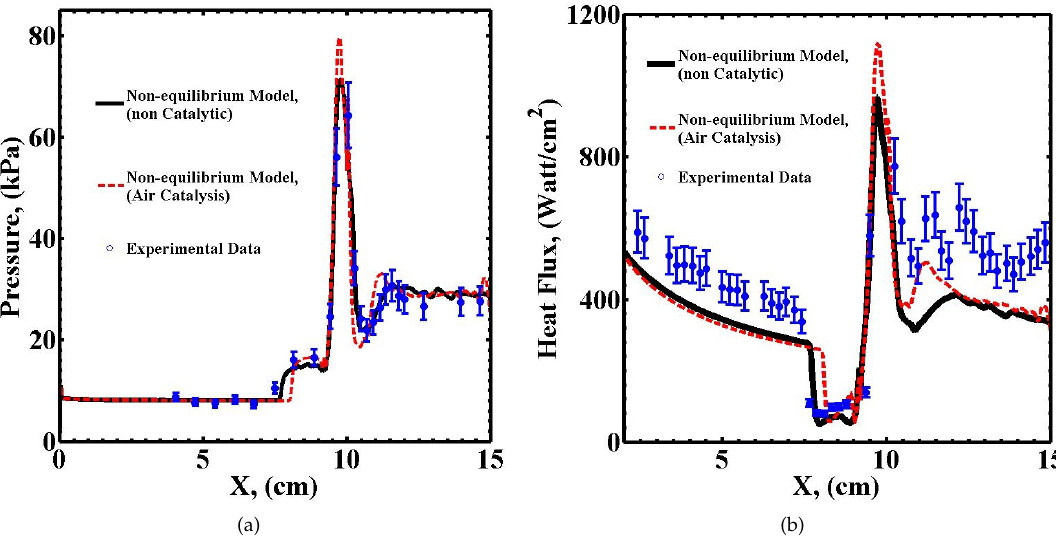
Figure 11. Computational results for Run 4, Table 1, using the non-equilibrium Navier–Stokes model. ( a ) Surface pressure; ( b ) Heat transfer